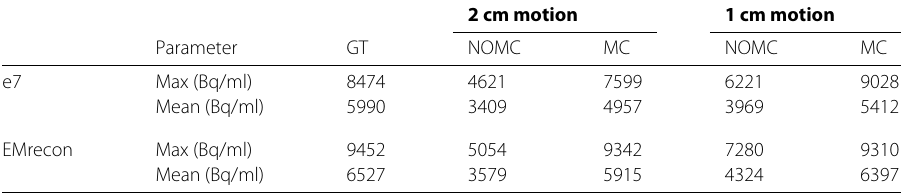
Table 2 Activity concentrations of phantom data for all reconstructions